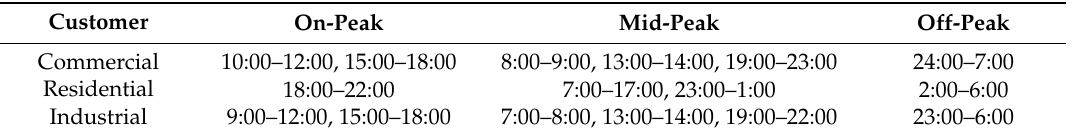
Table 2. Time period partition.